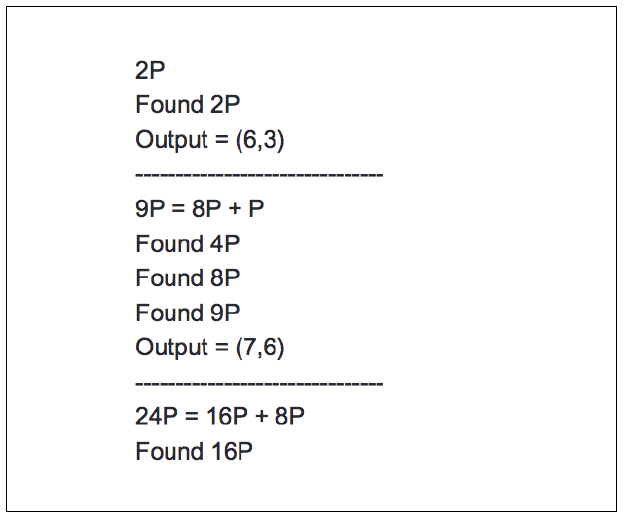
Figure 2. Computing the point 24P by using remi_func and remi_point